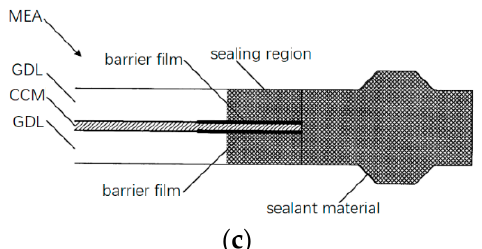
Figure 5. A partial cross-sectional view of the edge of the MEA, impregnate MEA with sealing material to form an integral seal. ( a ) Impregnate the MEA with sealing material [39]; ( b ) two fuel cell separators clamp the integral seal [39]; ( c ) insert a barrier film between the MEA and the sealing material [40].